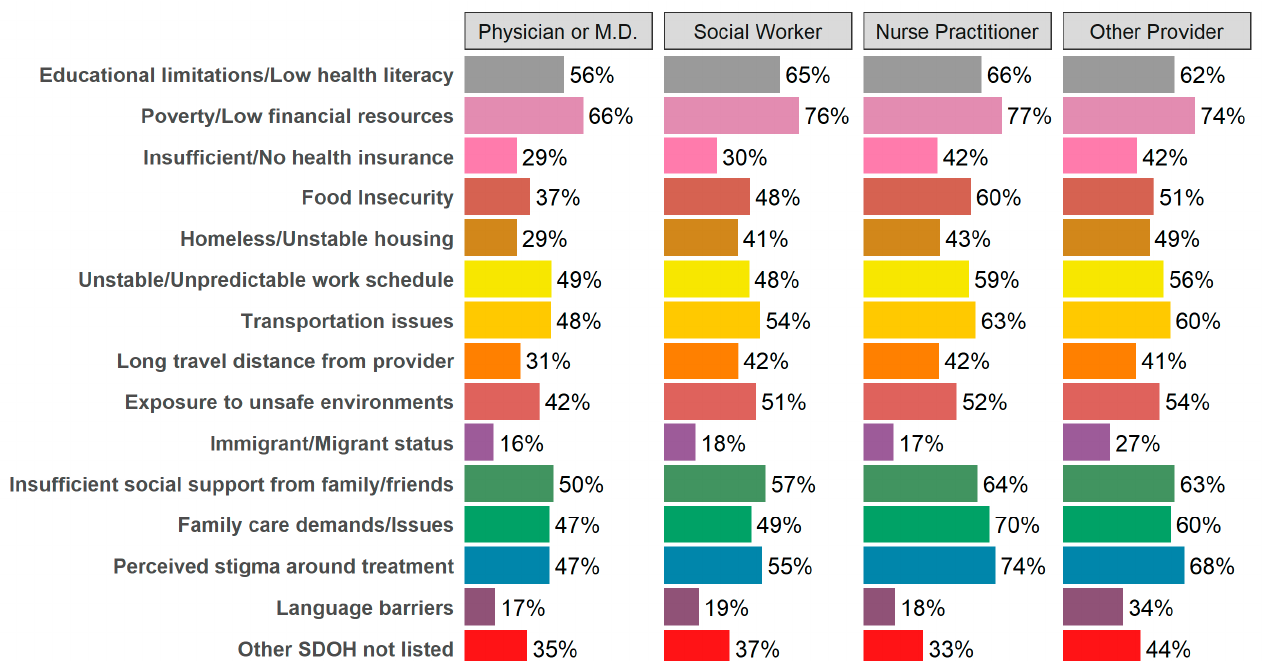
Figure 1. Heatmap of bivariate correlations for healthcare provider reports on portion of their pa- tients experiencing each